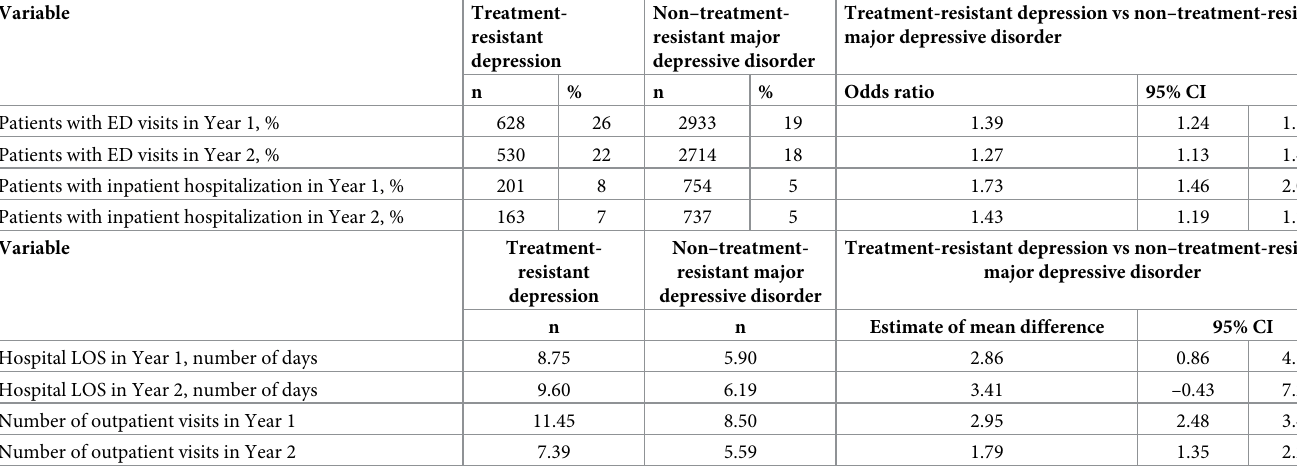
Table 2. Healthcare resource utilization per year during the study